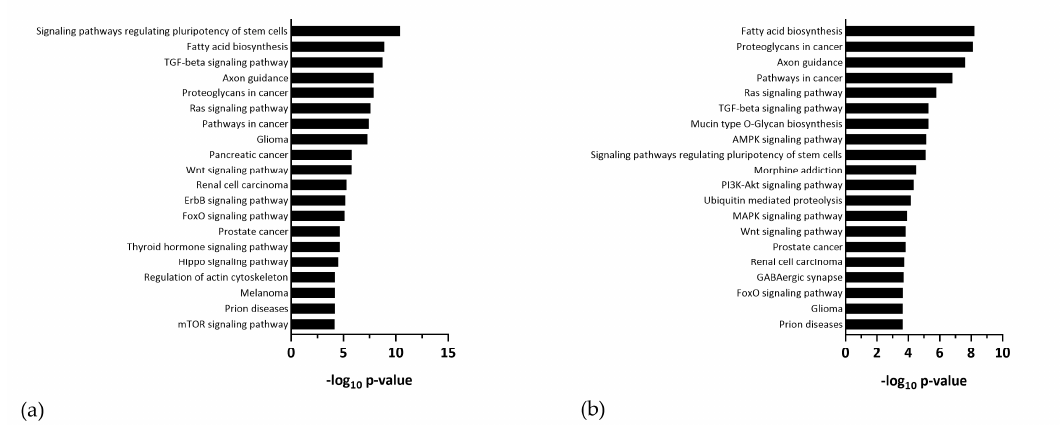
Figure 8. KEGG Pathway analysis of potential targets of EV-derived miRNAs which were differentially incorporated following infection with ( a ) ZIKV Polynesia and ( b ) ZIKV Uganda. Table 4. miR-4792: Diana mirPath v3 gne ontology analysis.